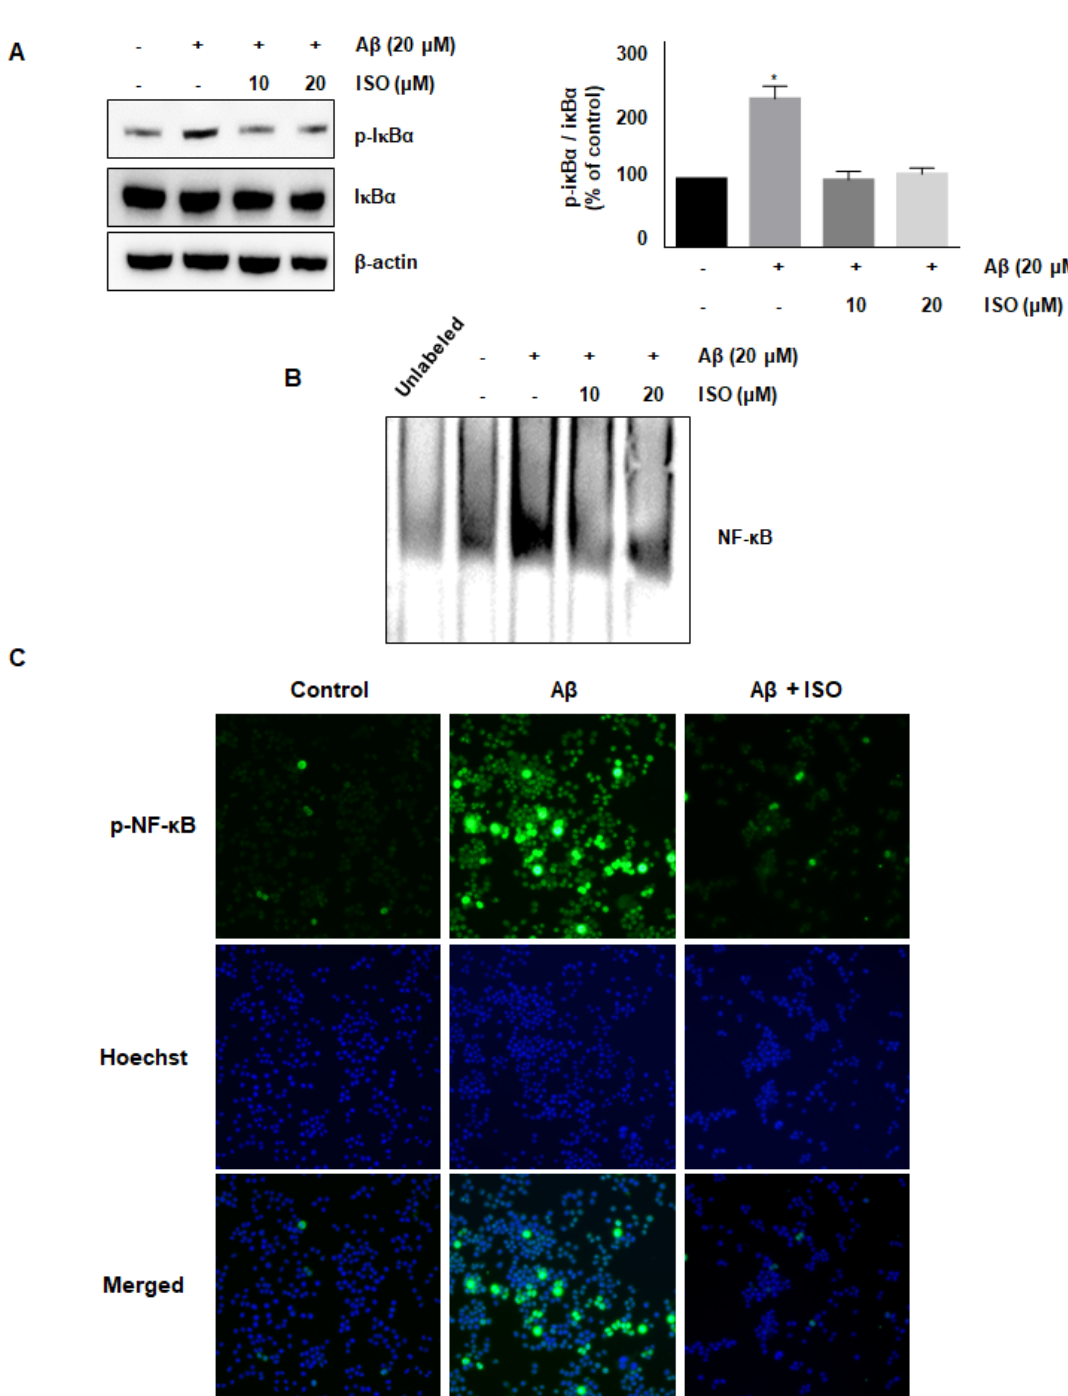
Figure 3. ISO inhibits the A β 25–35 -mediated NF- κ B signaling pathway. BV2 cells were pretreated with different concentrations of ISO as indicated 1 h before the addition of A β 25–35. ( A ) The phosphorylation level of I κ B α was determined by Western blotting using a cytosolic extract. Data indicate mean ± SEM of three independent experiments. * p < 0.05 versus control ( B ) Nuclear extracts of BV2 cells were analyzed by EMSA. ( C ) The immunofluorescence assay was performed to detect NF- κ B nuclear localization. Stained BV2 cells were visualized by a fluorescence microscope (200 × magnification).